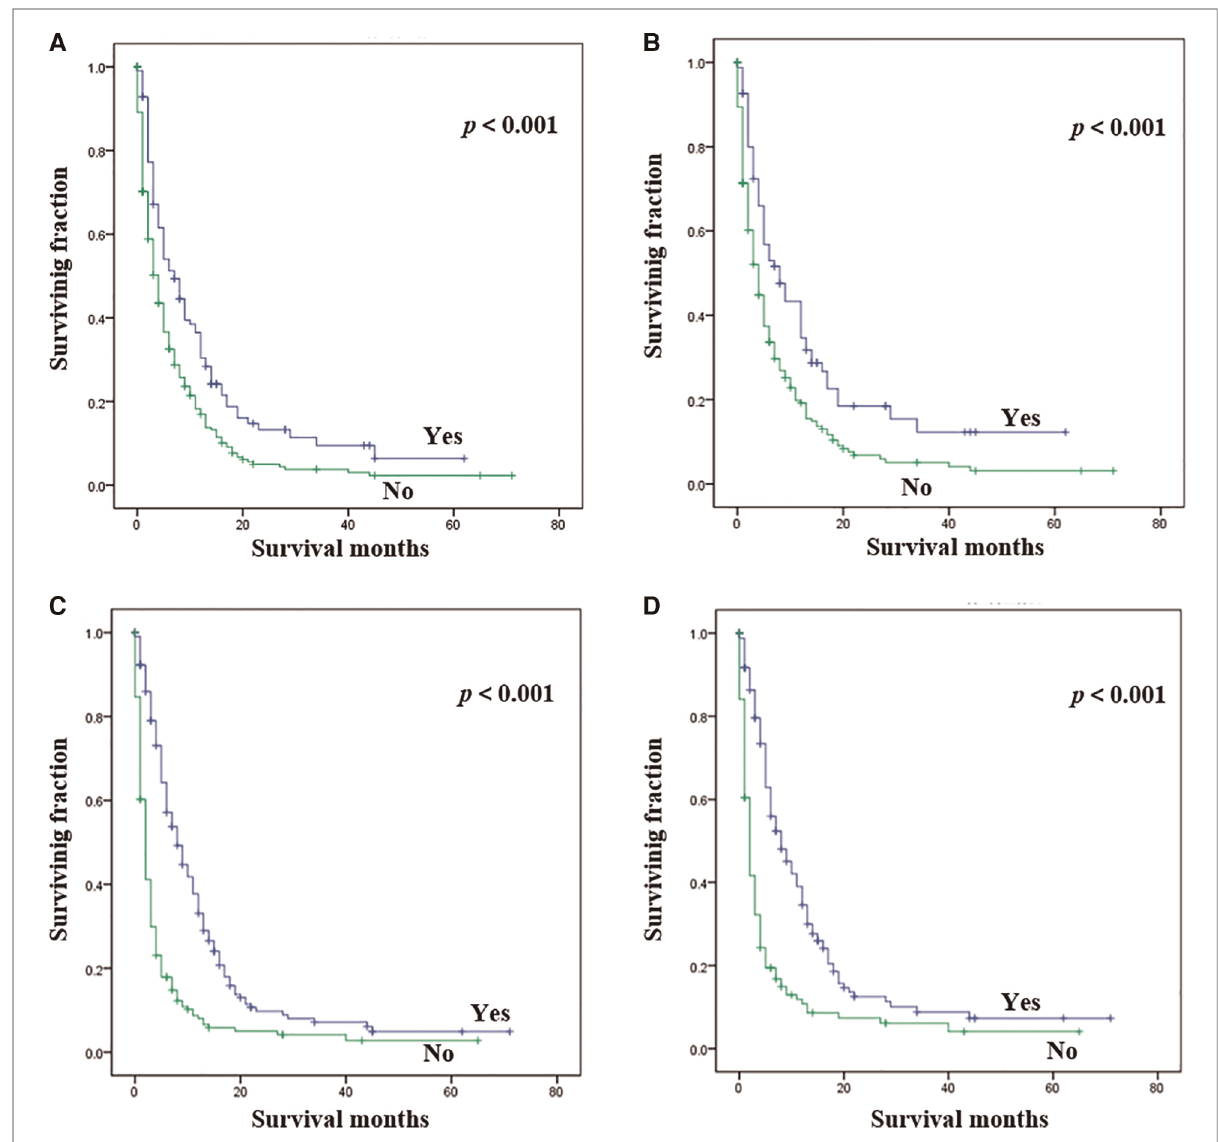
FIGURE 2 Kaplan-Meier method estimated OS and CSS in UTUC patients with bone metastasis strati fi ed by treatment methods. ( A ) OS strati fi ed by surgery; ( B ) CSS strati fi ed by surgery; ( C ) OS strati fi ed by chemotherapy; ( D ) CSS strati fi ed by chemotherapy. (UTUC, upper-tract urothelial carcinoma; OS, overall survival; CSS: cancer-speci fi c